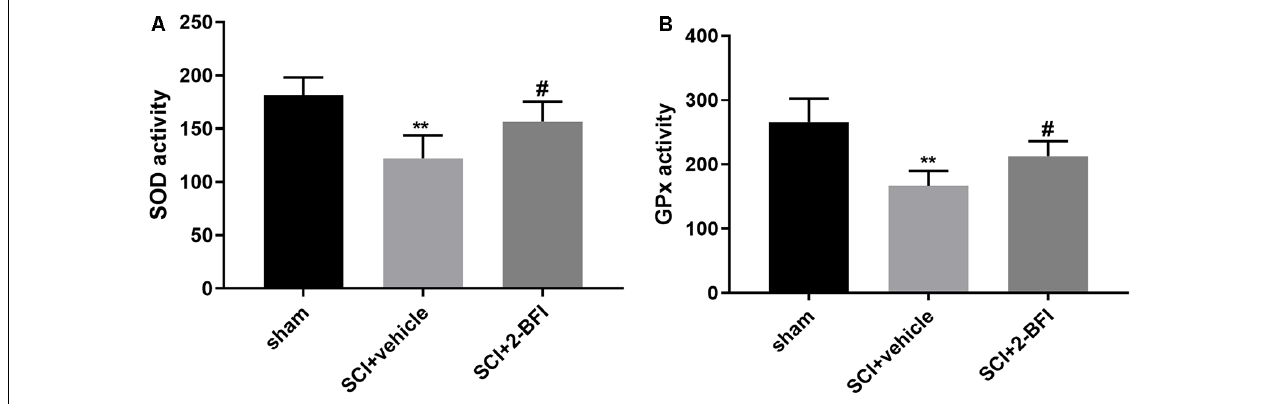
FIGURE 5 | The levels of superoxidase dismutase (SOD) and glutathione peroxidase (GPx) in spinal cord tissue samples were estimated by ELISAs (A,B) . n = 6 animals per group. Columns represent the mean ± SD. ∗∗ P < 0.01 vs. the sham group; # P < 0.05 vs. the SCI+vehicle